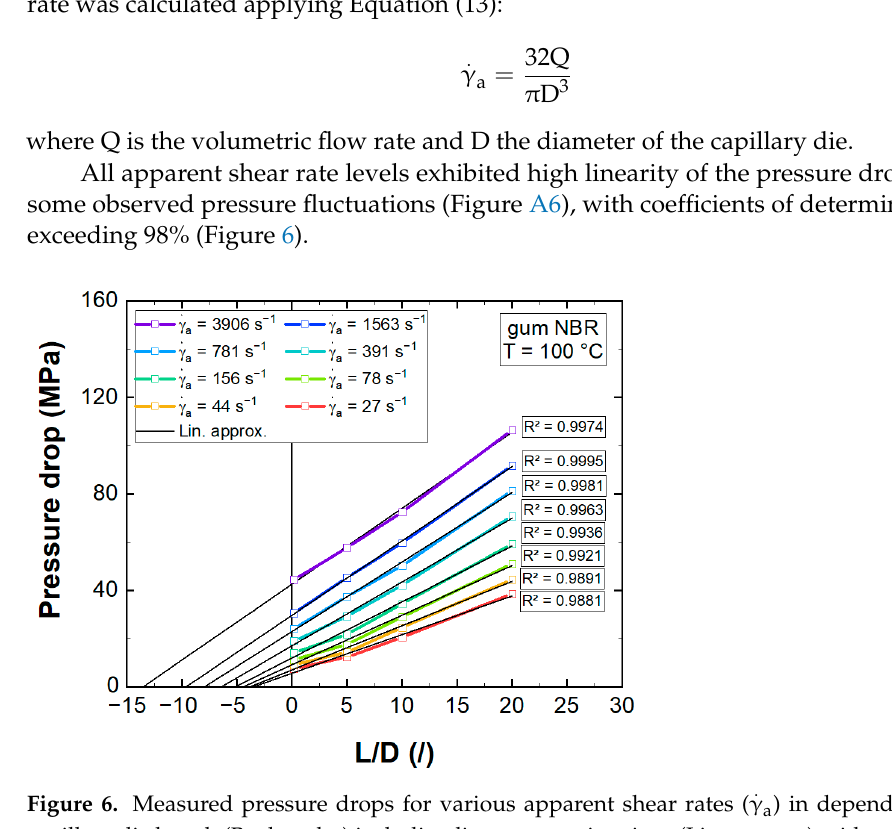
Figure 6. Measured pressure drops for various apparent shear rates ( γ(cid:4662) (cid:2911) ) in dependence of the capillary die length (Bagley plot) including linear approximations (Lin. approx.) with coefficients of determination (R²).